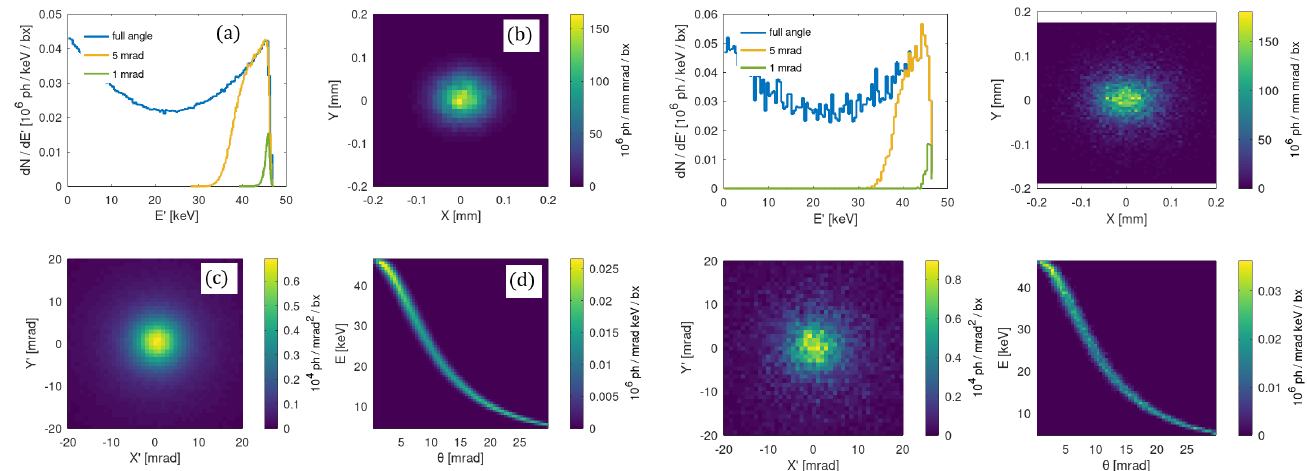
Figure 6. Comparison of plots from ThomX simulation using RF-Track ( left ) and CAIN ( right ). ( a ) The photon energy spectrum in a 1mrad and 5mrad collection angle, along with the full angle spectrum. ( b ) The transverse source size. ( c ) The angular emission distribution. ( d ) The number of photons/mrad 2 /s against energy and collection angle.